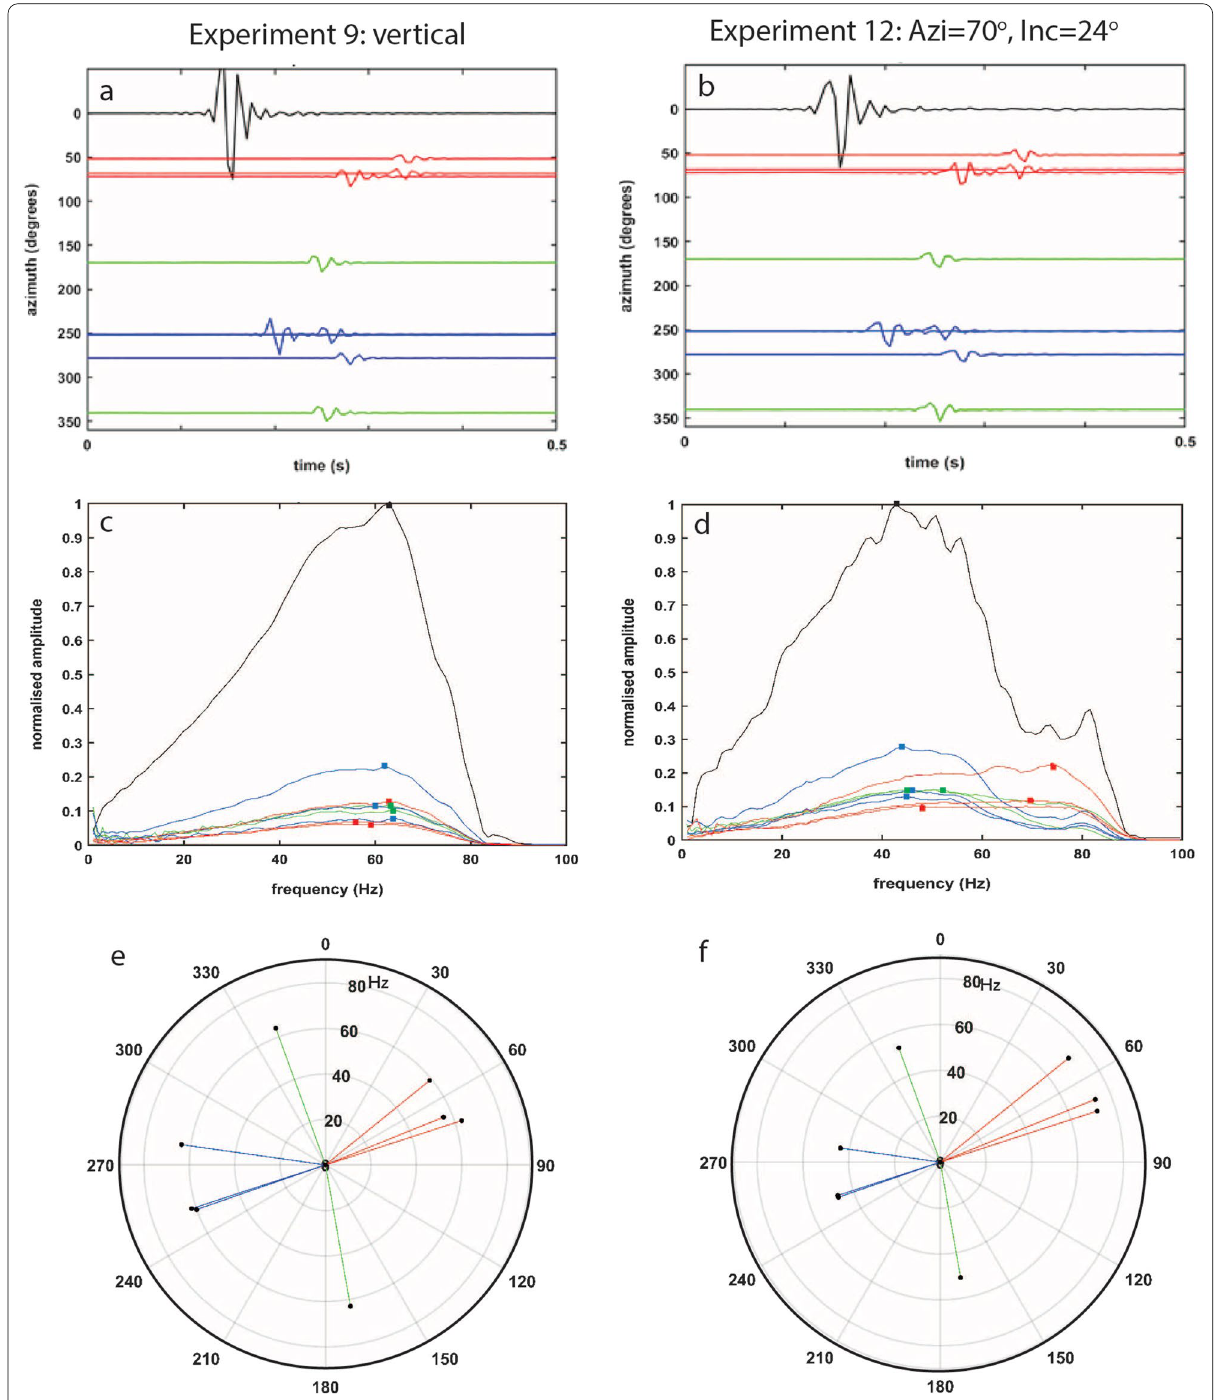
Fig. 3 Example acoustic waveforms ( a , b ) and spectra ( c , d ) for vertical ( a , c ), and northeast-directed ( b , d ) blasts. Color is representative of the station distribution in Fig. 1. Example polar plots ( e , f ) show peak spectral frequencies (0–100 Hz with low frequencies in plot center) and station azimuth (1°–360° clockwise from North at the top) relative to the source position (SRC). Squares mark maximum frequency of each spectra as shown ( e , f ) note for lateral discharge shown in d and f the higher frequencies northeastward and diminished frequencies southwestward. The window onset for a and b is ~ 0.1 s prior to the explosion onset for each